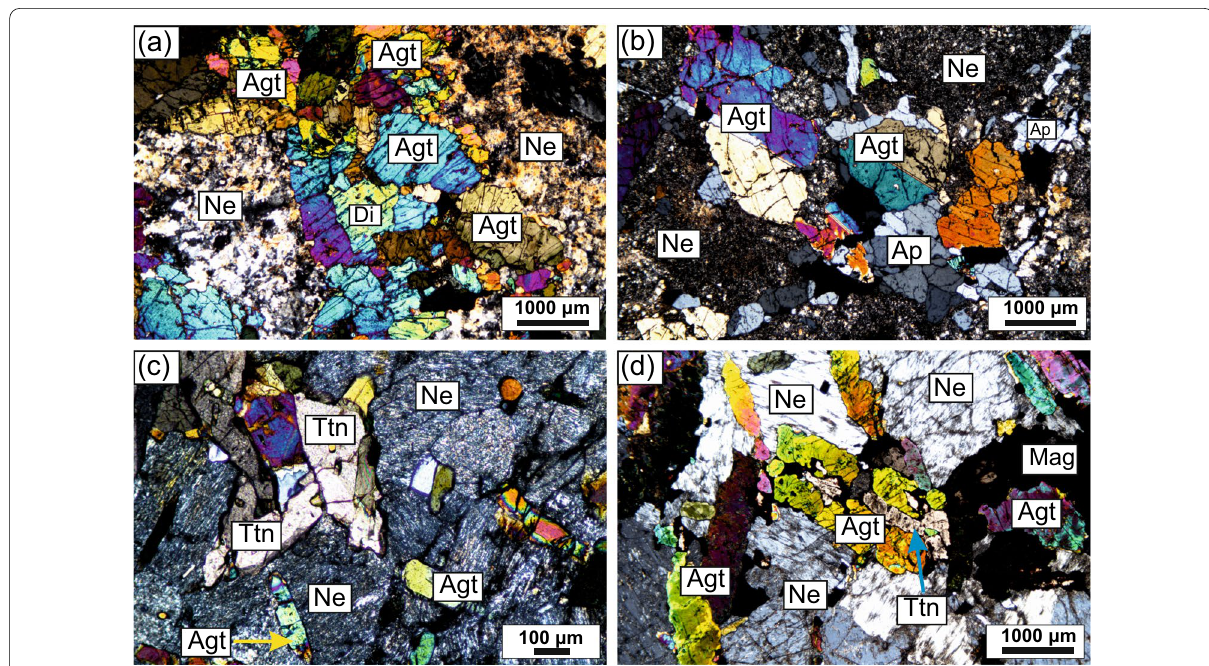
Fig. 2 Petrographical photomicrographs of representative samples from Sung Valley ijolites in cross-polarized light. a Subhedral diopside, aegirine-augite, and nepheline forming the hypidiomorphic texture. b Subhedral to anhedral aegirine-augite showing simple twining along with the apatite and nepheline. c Aegirine-augite enclosed by nepheline with subhedral to anhedral titanite crystals forming the poikilitic texture. d Subhedral aegirine-augite, titanite, nepheline, and magnetite showing hypidiomorphic texture. Aeg-Aug Aegirine-augite; Di Diopside; Ne Nepheline; Ap Apatite; Ttn Titanite; Mag